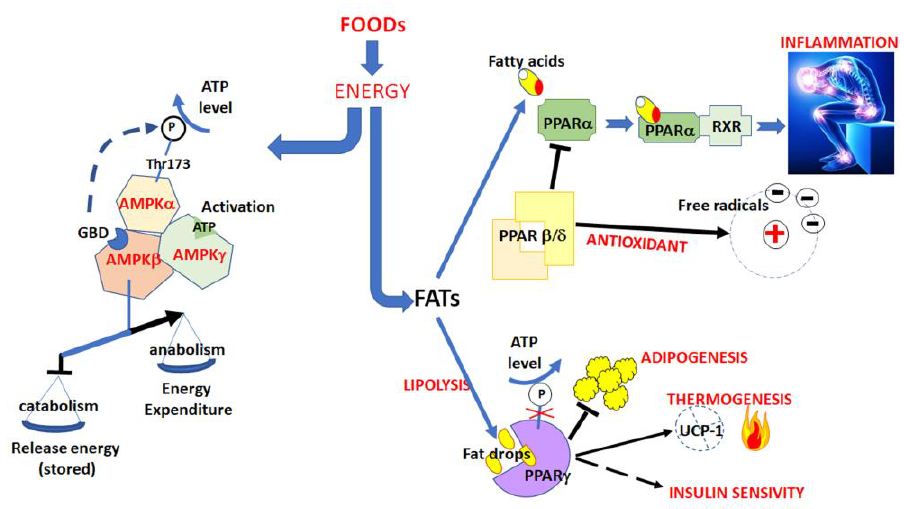
Figure 2. Effects of nutrition on AMPK and PPARs pathways.